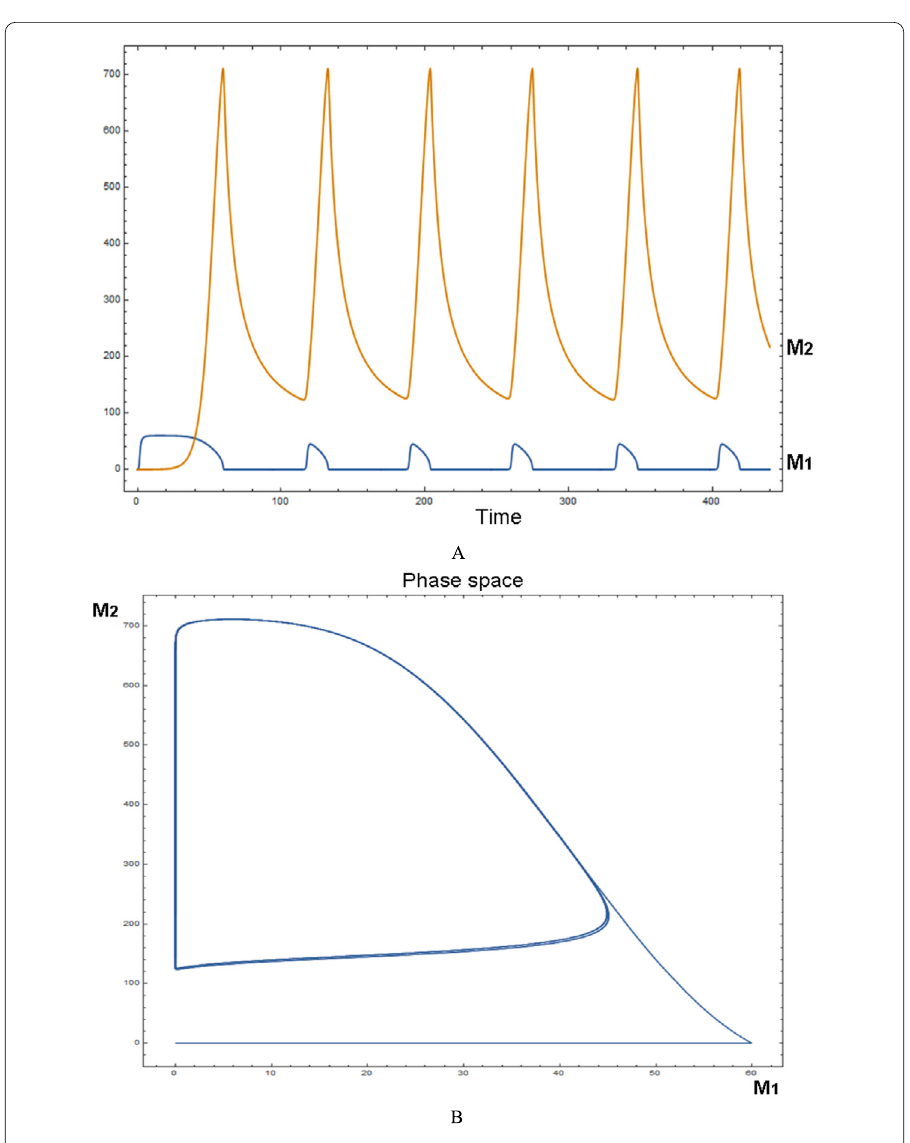
Figure 5 Time series showing the existence of periodic solutions at the steady state equilibrium neighborhood giving birth to a stable limit cycle in A and the phase portrait in B for M 1 (0) = 0.09, M 2 (0) = 0.02, a 1 = 0.07, b 1 = 0.015, V = 60, a 2 = 0.023, b 2 = 0.06, a 3 = 0.3, n = 0.9, m = 0.8